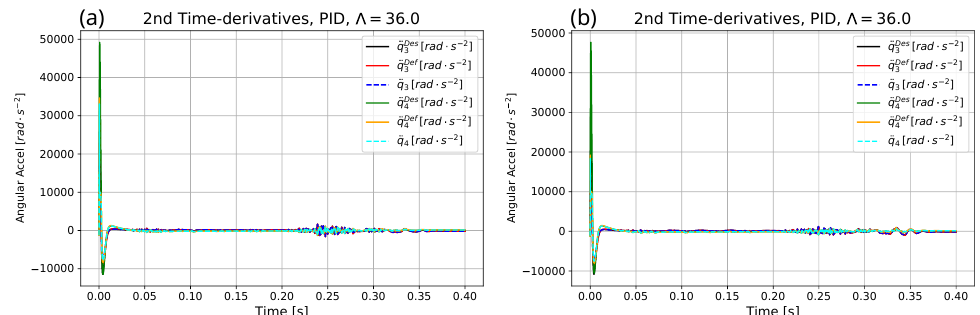
Figure 8. Second time derivatives without force limitation for the joint coordinates q 1 ( t ) and q 2 ( t ) without the initial transient. ( a ) For set 1. ( b ) For set 2.